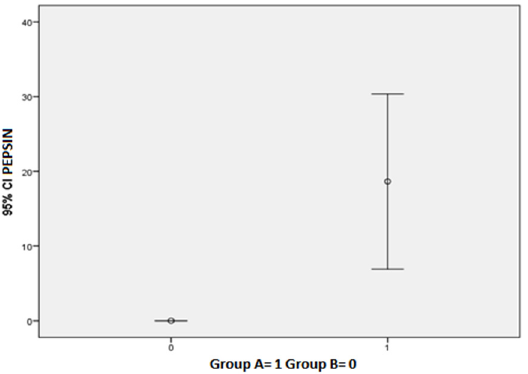
Figure 1. Group A patients showed a statistically significant higher value of Pepsin ( p = 0.027). Table 2. Summary of the results, comparing Group A with Group B.